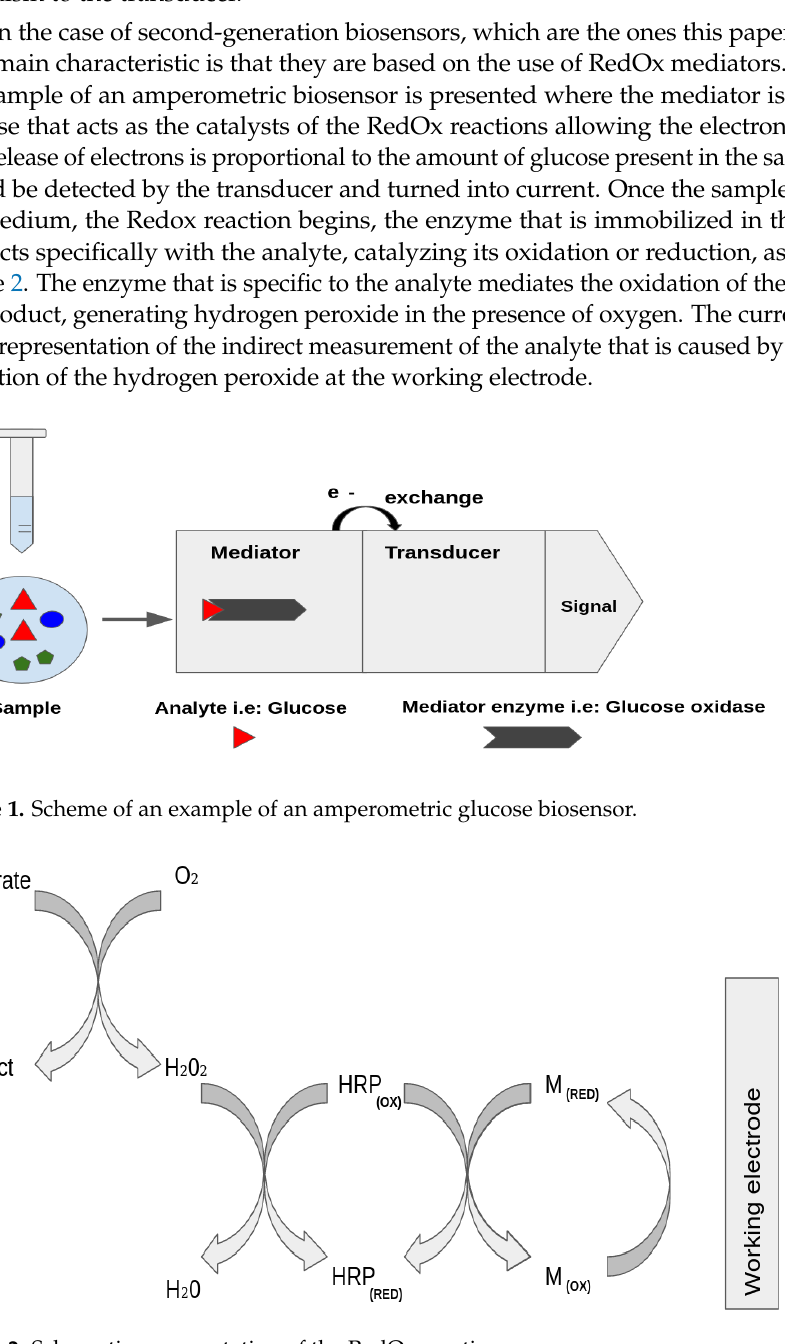
Figure 2. Schematic representation of the RedOx